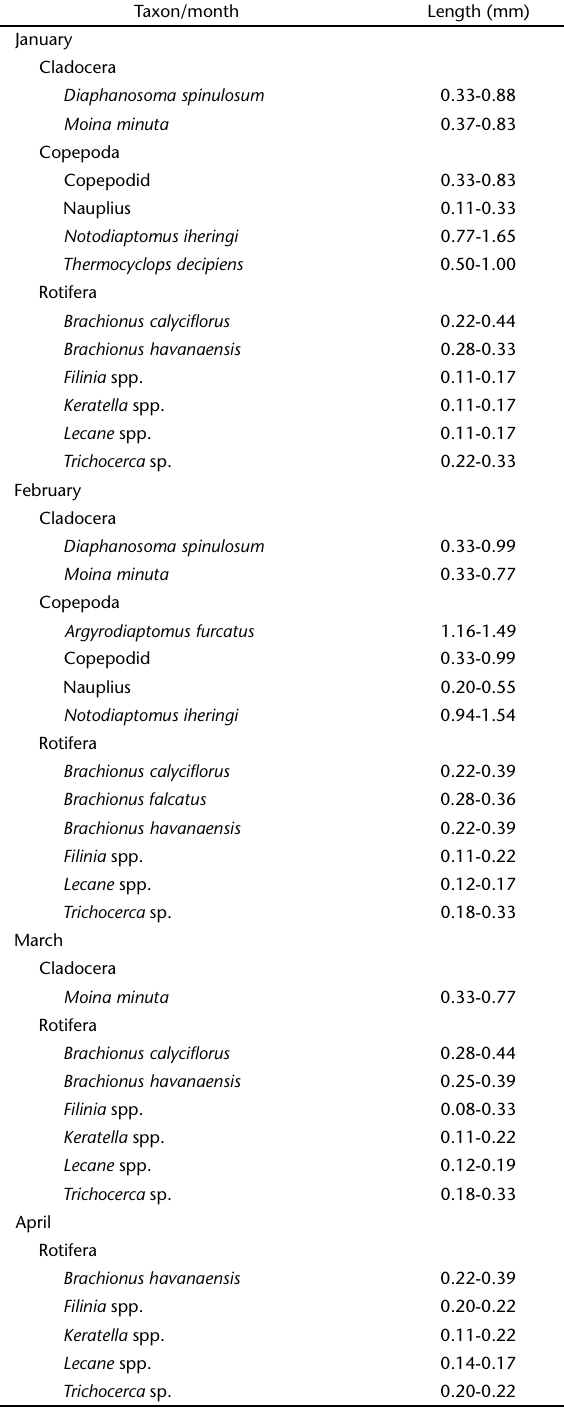
Table 2. Size variation from Oreochromis niloticus and their structures responsible for filtering zooplankton community throughout the study. Values are means (± standard